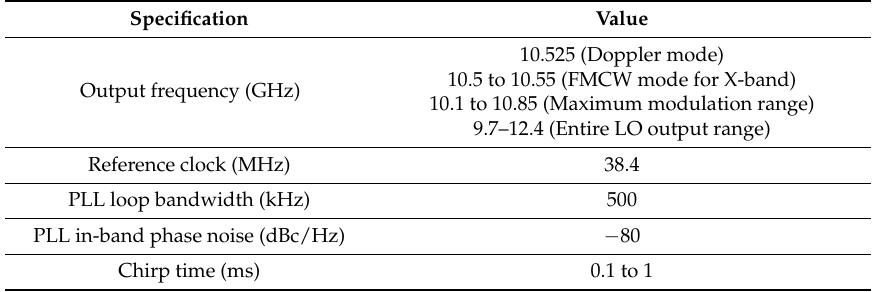
Table 1. Parameters of the proposed dual-mode